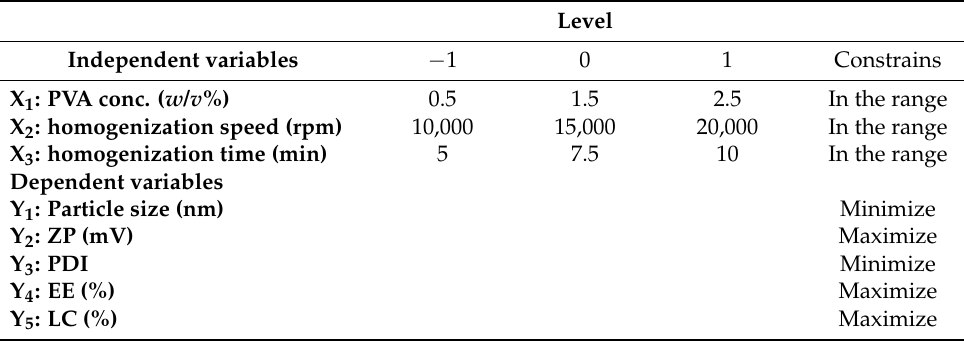
Table 1. Variables and constrains in Box–Behnken experimental